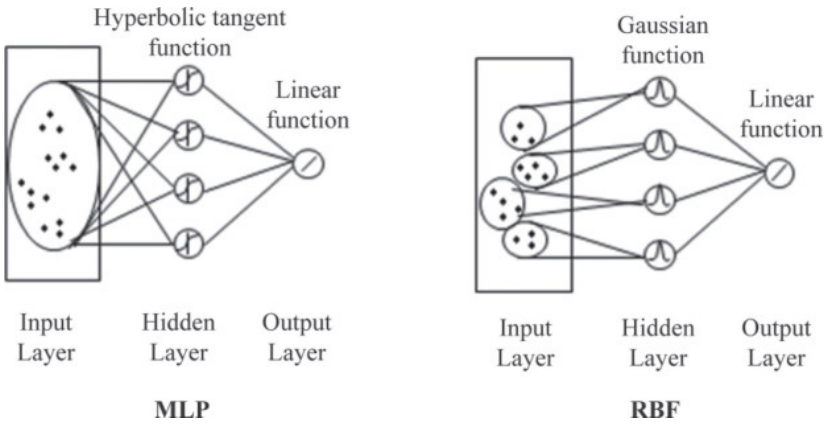
Figure 11. MLP and RBFN [100].